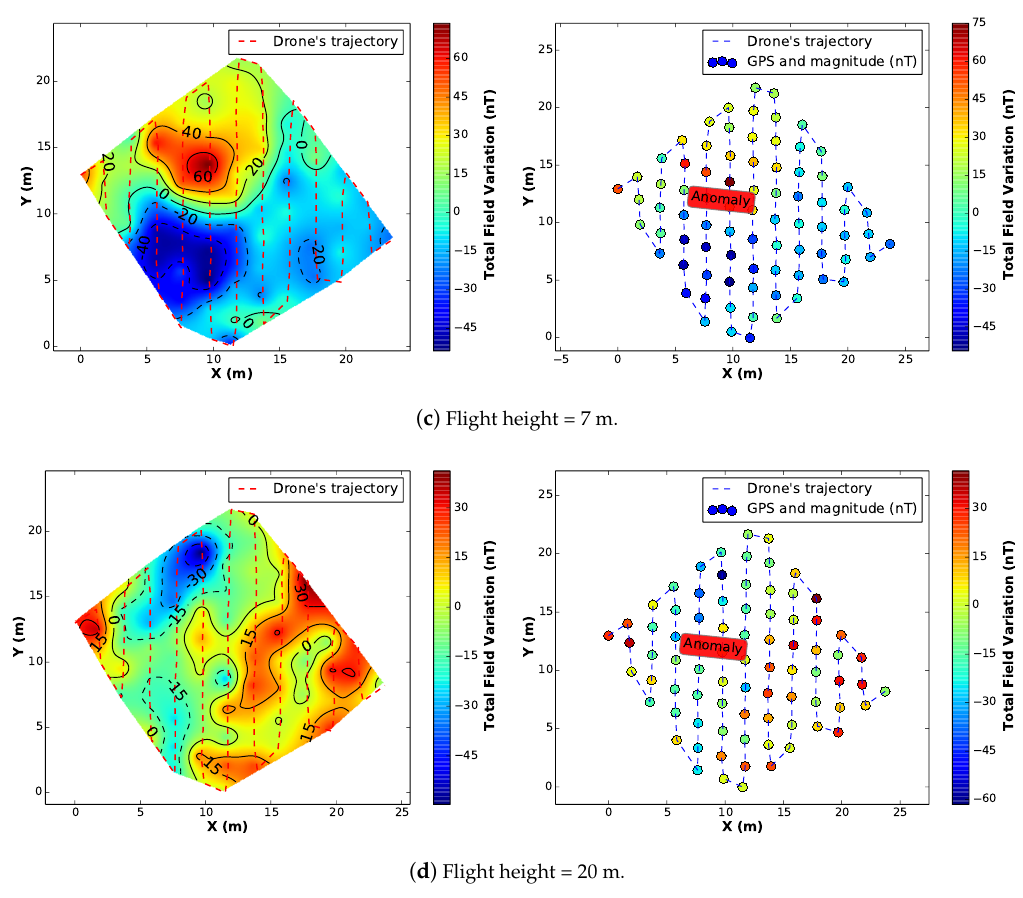
Figure 16. Generated maps from the complete survey at different heights with a artificial anomaly placed in the hightlighted position on the right (sparse)